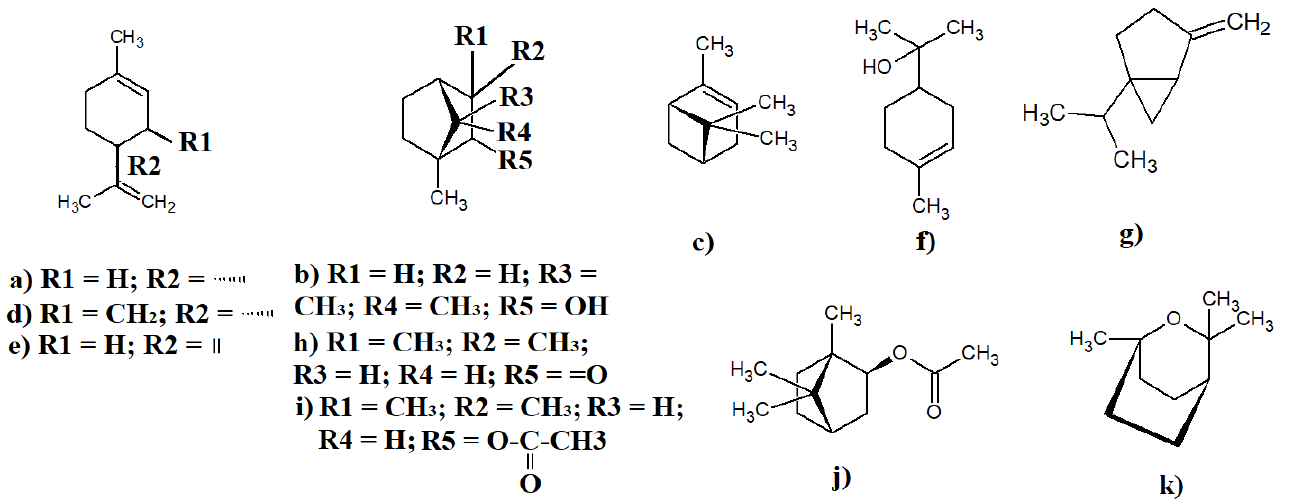
Figure 3. Selected monoterpenoids identified in Eremophila spp.: ( a ) D-limonene; ( b ) borneol; ( c ) α-pinene; ( d ) menthone; ( e ) terpinolene; ( f ) α-terpineol; ( g ) sabinene; ( h ) fenchone; ( i ) fenchyl-acetate; ( j ) bornyl-acetate; and ( k ) cineole.